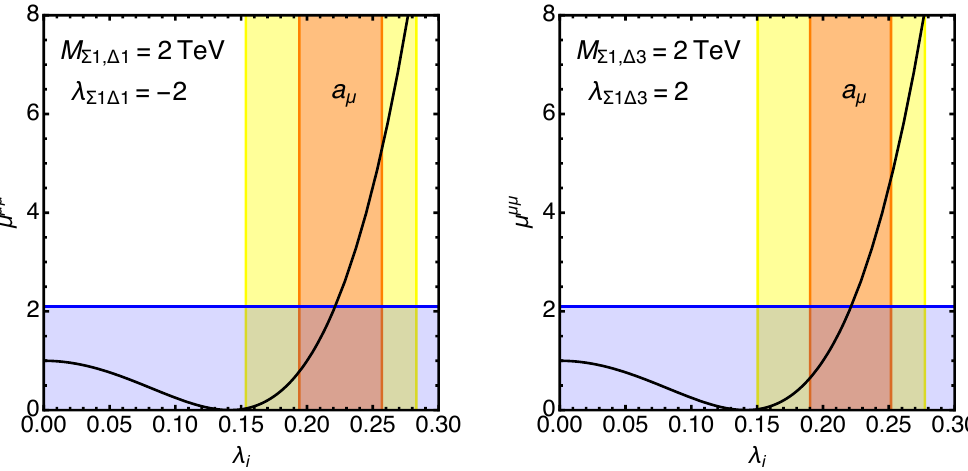
Figure 4. Signal strength of h ! (cid:22)(cid:22) as a function of the Yukawa coupling (cid:21) i . Here, (cid:21) i (cid:17) (cid:21) (cid:6) = (cid:21) (cid:1) 1 1 with (cid:21) (cid:1) = 0 (left) and (cid:21) i (cid:17) (cid:21) (cid:6) = (cid:21) (cid:1) with (cid:21) (cid:1) = 0 (right). Also, j (cid:21) (cid:6) j = 2 and M i = 2 TeV. 3 1 3 1 1 (cid:1) 1 ; 3 The blue region is allowed at 95% level by a search for h ! (cid:22)(cid:22) at ATLAS. The discrepancy in the muon g (cid:0) 2 is explained at the 1 (cid:27) (2 (cid:27) ) level by the Yukawa couplings in the orange (yellow)